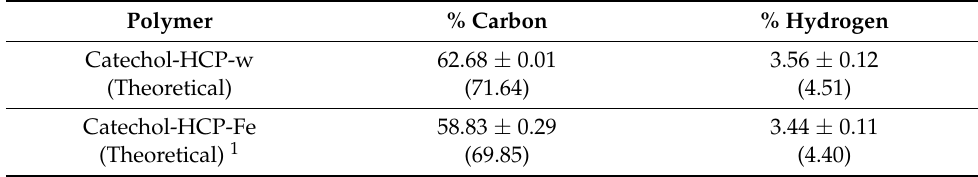
Table 1. Elemental analysis of HCPs.